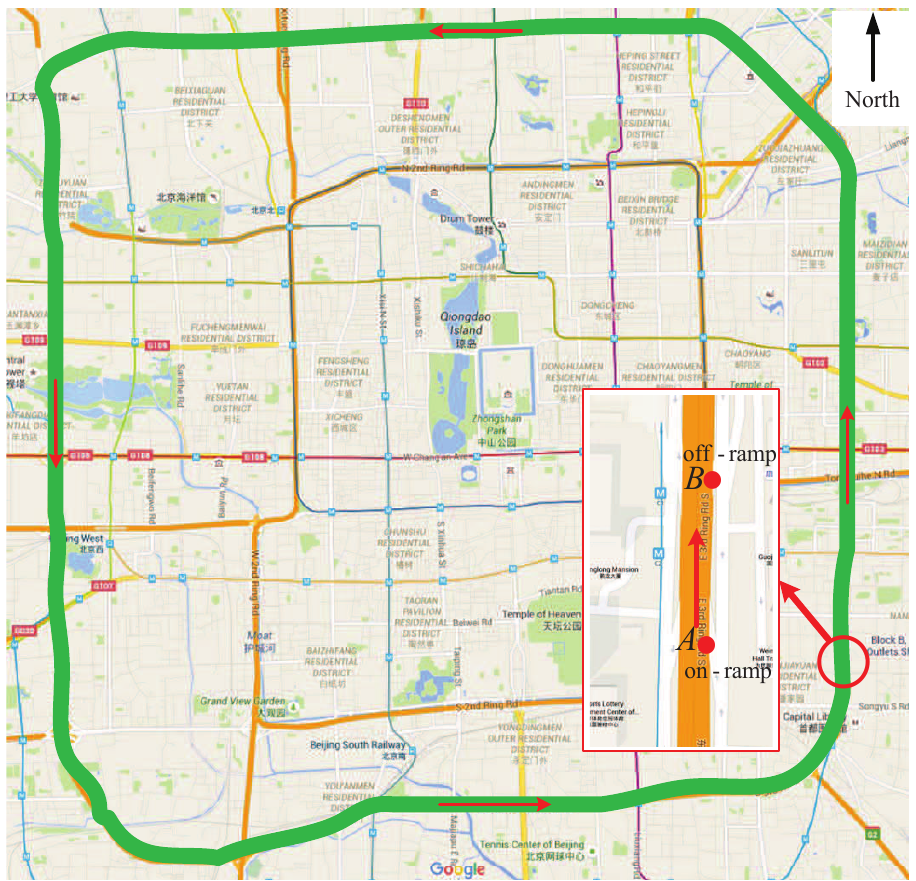
Figure 6. Beijing third ring freeway (from Google Map). The points A and B are marked as the first on-ramp and the first off-ramp, respectively. The segment between A and B is labeled as cell 1. (Note: The Chinese word in this map is just the name of some buildings and will not affect the meaning of this